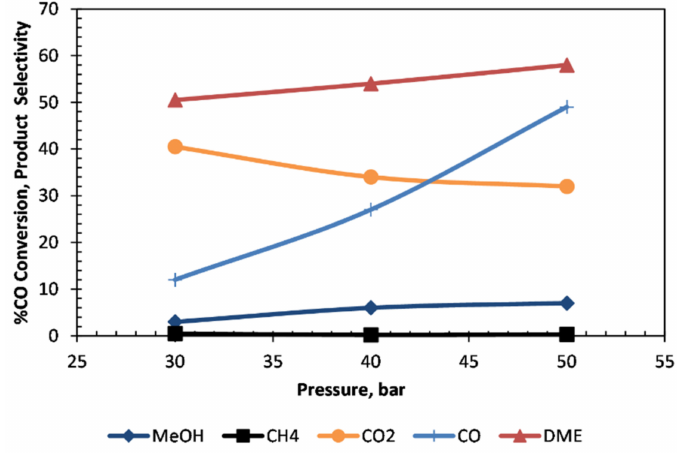
Figure 10. Effect of reaction pressure on product distribution (T = 275 ◦ C; P = 30–50 bar; CO/H 2 :1/1 as feed